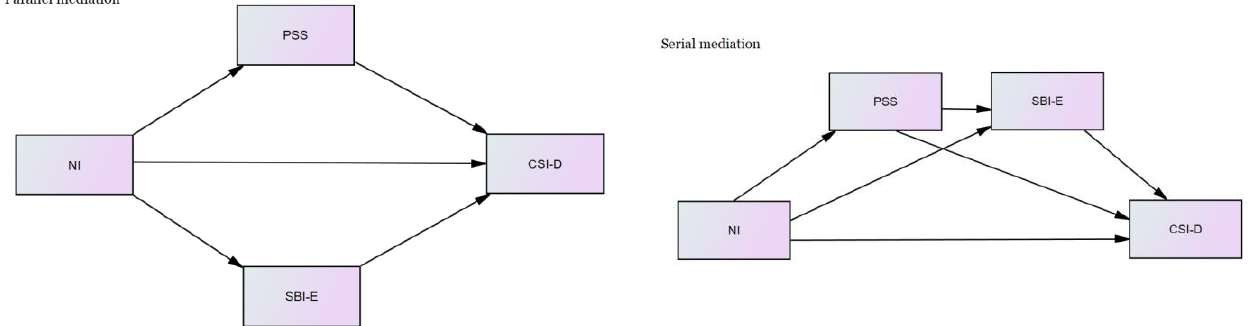
Figure 1. Proposed parallel and serial mediation models.